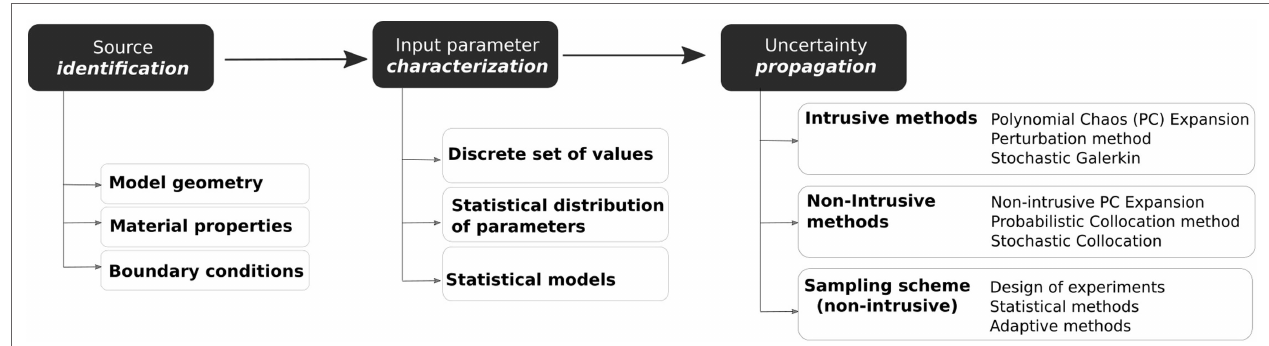
FIGURE 1 | General workflow analysis of input uncertainty and variability in computational models: (1) identification of all sources of uncertainty, (2) characterization of model input uncertainty, and (3) propagation of input uncertainty through the model .